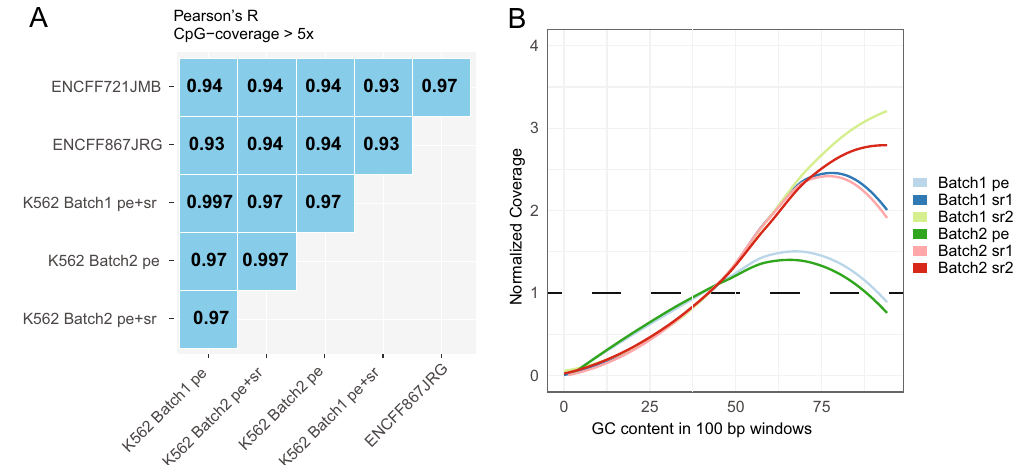
Figure 2. Assessment of methylation levels and GC bias in pseudo-bulk scSPLAT K562 data. ( A ) Single cell data were merged batch-wise to produce ‘pseudo’ bulk data sets. Pairwise methylation correlation was computed across the pseudo-bulk SPLAT data and two sets of K562 ENCODE bulk WGBS data. Pearson’s R values are shown for comparisons across ENCODE sets and pseudo-bulk SPLAT mapped in paired-end (pe) mode as well as in combined paired end and single read mode (pe + sr). ( B ) GC bias profiles for batch-wise merged pe and sr mapped reads respectively. Coverage was shifted towards genomic regions of higher GC content, especially for the sr mapped data (reads that were unmappable in pe mode and subsequently mapped as single